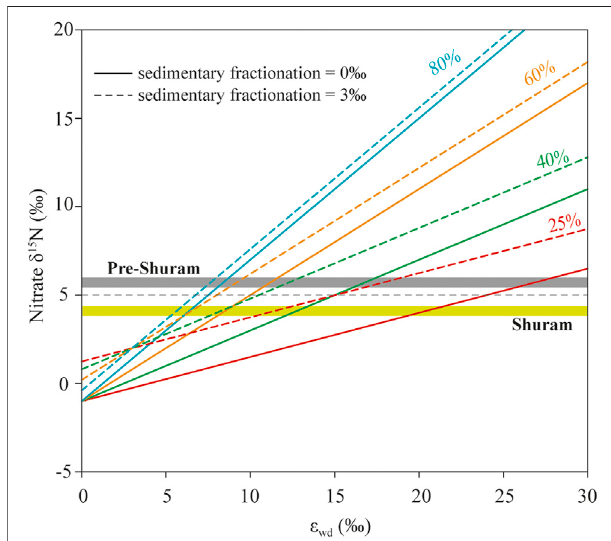
FIGURE 8 | Mass balance model showing seawater nitrate δ 15 N as function of ε wd . Colored oblique lines represent the fraction of water column denitri fi cation (f wd ) from 25% (red line) to 80% (blue line). Horizontal dash line indicates the average δ 15 N and modern seawater. Shaded zones show the bootstrap δ 15 N range (same as in Figure 7H ) before and during the Shuram